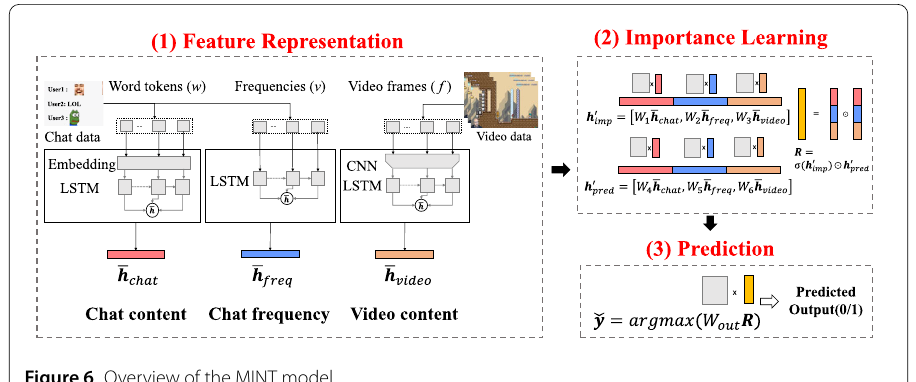
Figure 6 Overview of the MINT